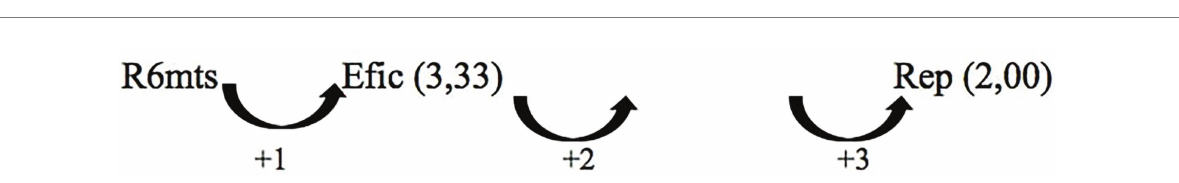
FIGURE 8 Association pattern between the focal conduct shot “R6mts” and the conditioned conduct attack result “Efic” and response of opponent “Rep” in Portugal National Team. R6mts, 6 m shot; Efic, goal or 7 m; Rep, throw-off.